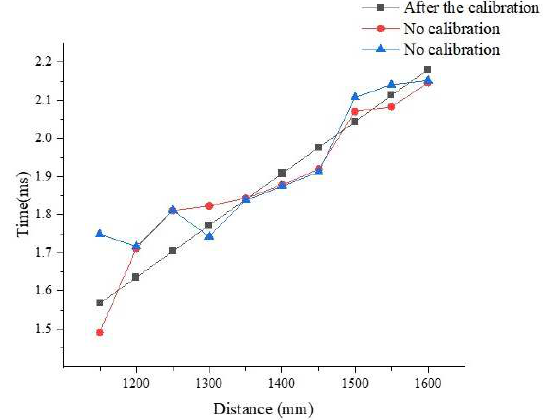
Figure 11. Comparison of data of transducer No. 1 before and after calibration.